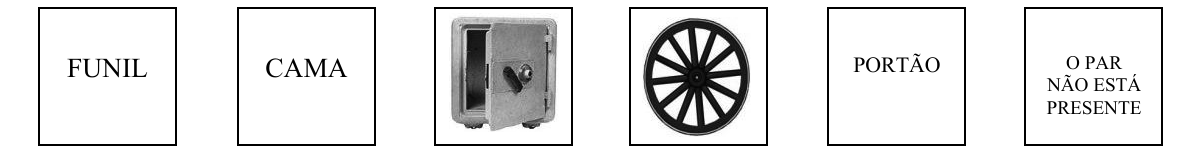
Figura 4 . Par de reconhecimento do teste de reconhecimento